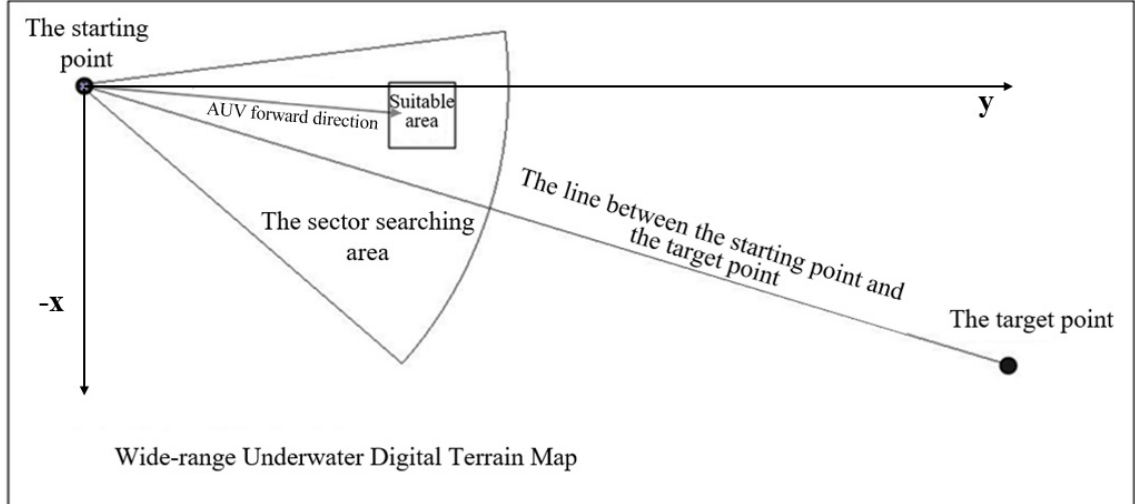
Figure 3. Diagram of sector searching method at the starting point.